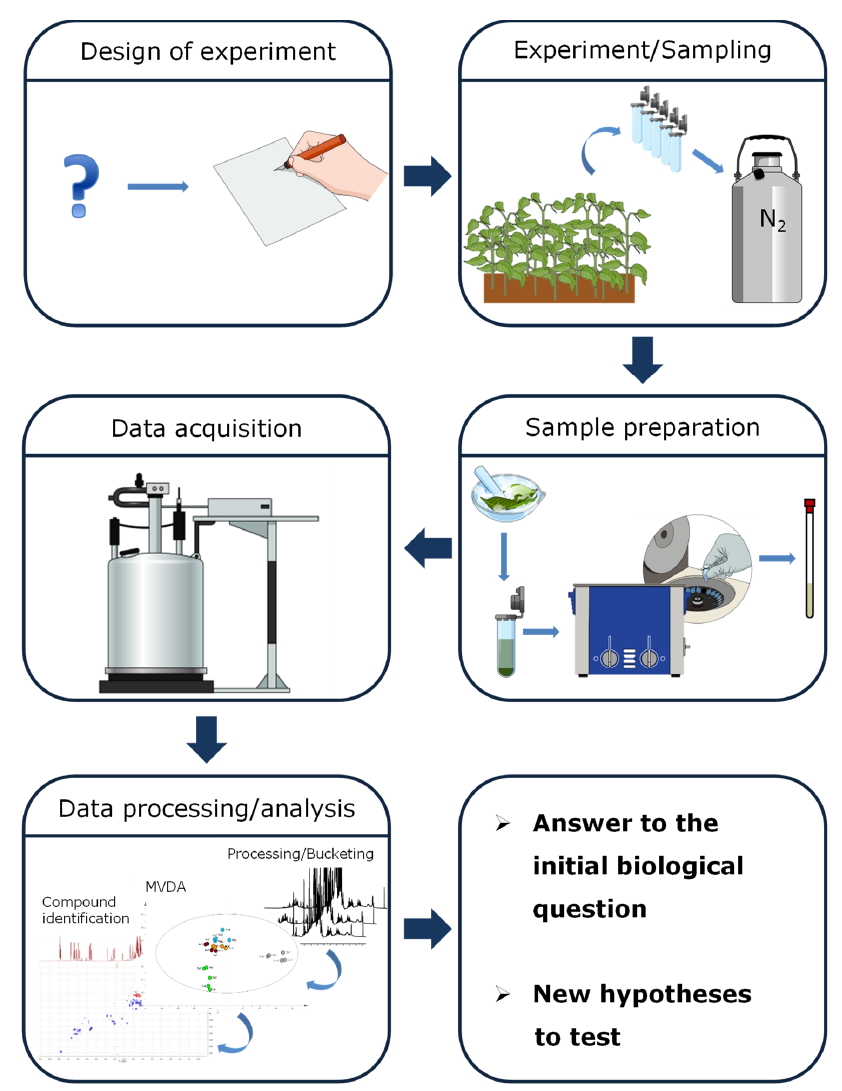
Figure 1. Pipeline of an NMR-based metabolomics experiment: in order to obtain results that are biologically and statistically significant a well-designed experimental approach is needed. This encompasses all the stages from sampling through data acquisition to data analysis (Figure created with mind the graph platform).